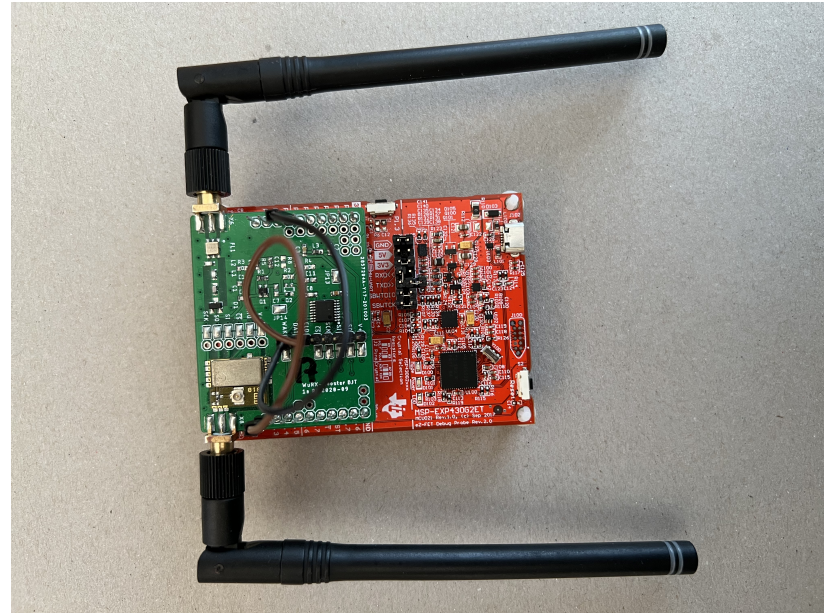
Figure 3. Wake-up Receiver equipped sensor node used in this